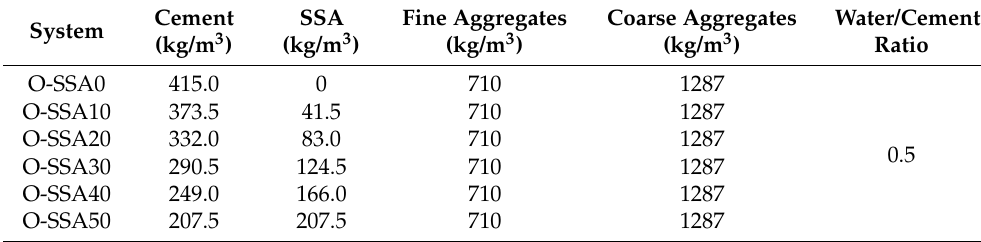
Table 3. Mix proportions of concrete with